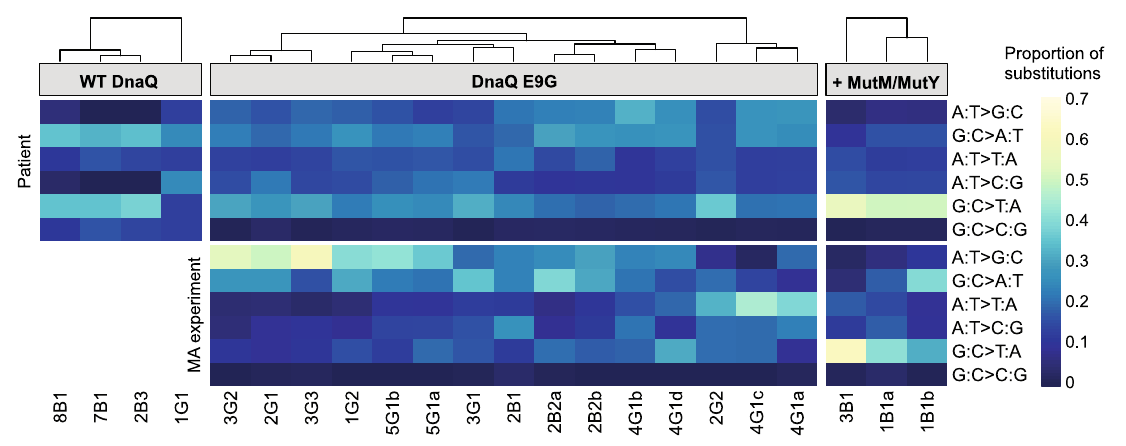
Fig. 4 Diversity of base-pair substitution spectra in B. hinzii isolates is largely explained by mutations in DNA repair pathways. Heatmap of clustered base-pair substitution spectra in patient isolates (top panel) and measured in mutation accumulation experiments (bottom panel). Relative mutation proportions are indicated by color for each of the base-pair substitutions as shown on the color scale legend (see Supplementary Table 5 for numeric data). Base-pair substitution frequency spectra in WT DnaQ patient isolates, DnaQ E9G isolates, and DnaQ E9G isolates with additional mutations in MutM or MutY genes were clustered using hierarchical clustering and indicated by dendrogram at the top. Mutational spectra detected in patient isolates are similar to those in the mutation accumulation experiments and are strongly affected by the DnaQ and MutM/MutY genotypes. Source data are provided as a Source Data fi